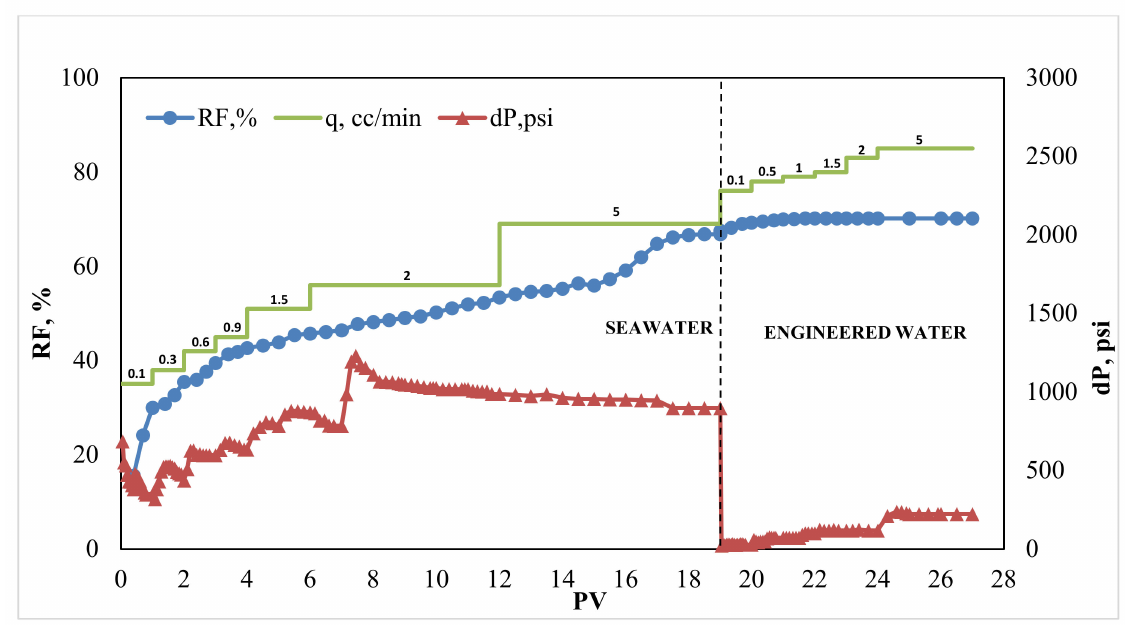
Figure 6. Engineered water (EW3) injection core flooding results (5 × Diluted CSW with 2Ca ∗ 2Mg ∗ 2SO 4